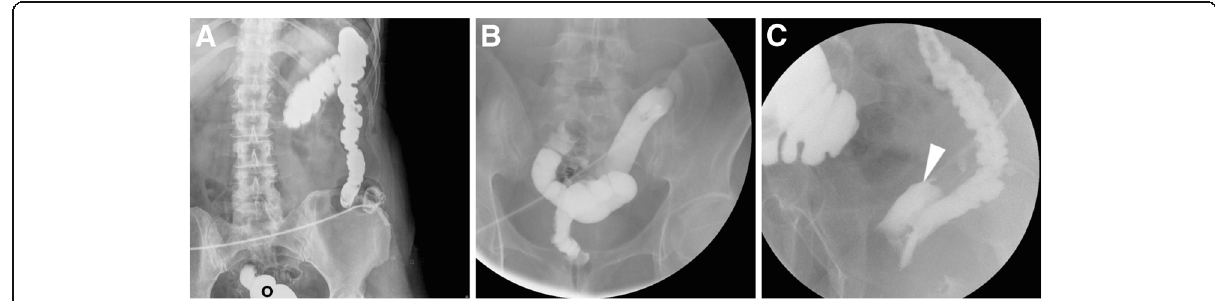
Fig. 3 Three examples of WSC-SE performed via colostomy. a After recent Hartmann ’ s surgery, retrograde opacification of closed rectal stump (o) was performed prior to WSC-SE at the descending colostomy. b In a different patient, WSC-SE performed at the efferent limb of a double- barrelled colostomy at the left iliac fossa depicts the diverted rectosigmoid tract. c at the end of a WSC-SE study, contrast opacifies the vagina (arrowhead) indicating the presence of a rectovaginal